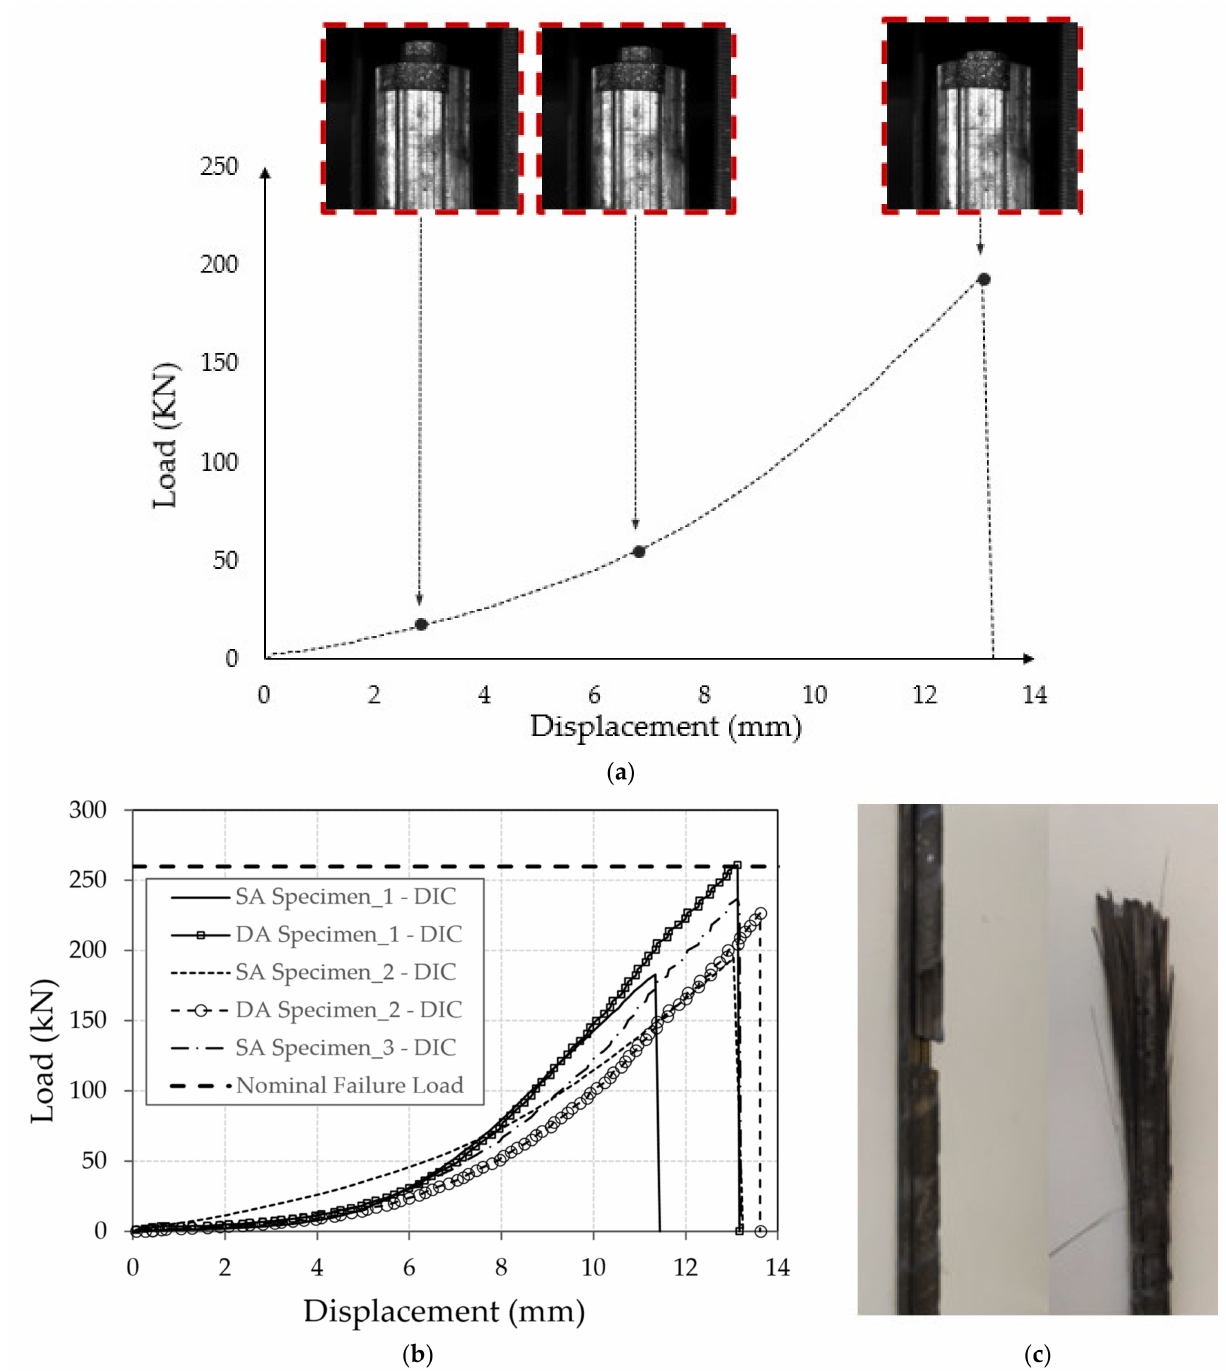
Figure 23. Proposed anchorage–Experimental tests: ( a ) force-displacement curve of the SA specimen_2: evolution of the top wedge displacement at three different levels of force and displacement (DIC results); ( b ) force-displacement curves of specimens (DIC results); ( c ) cable configuration after test (Left: SA_1 and SA_2; Right: DA_1, DA_2,